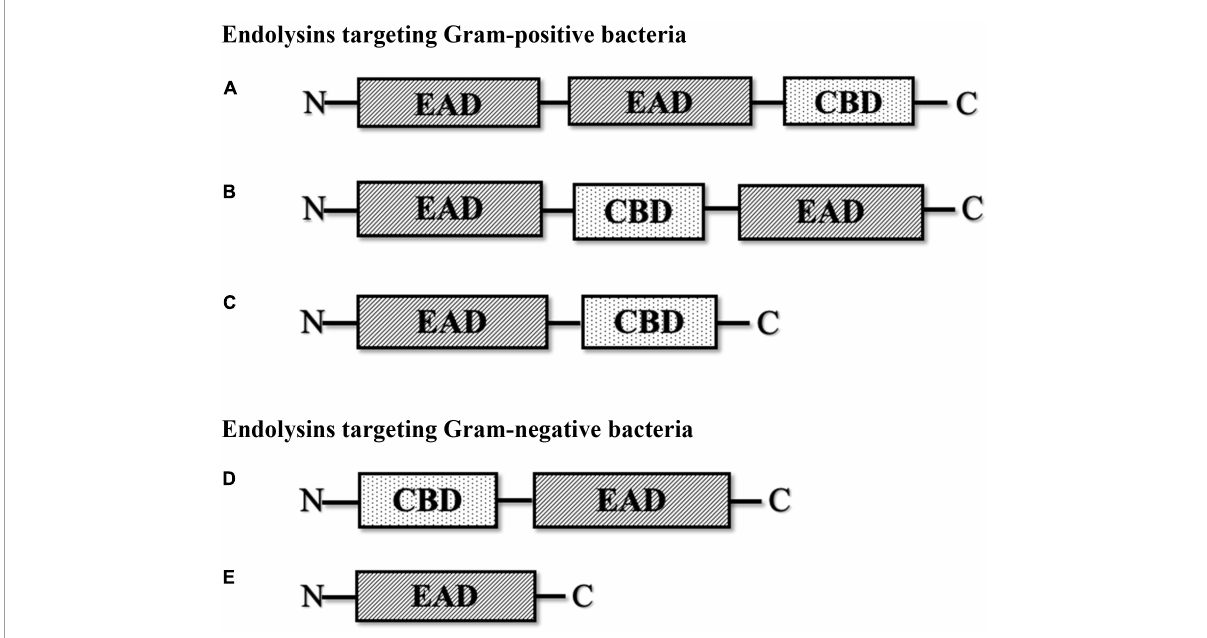
FIGURE1 Schematic structure of various types of phage-encoded peptidoglycan hydrolases (endolysin). (A) Multi-domain endolysin with more than one enzymatically active domain (EAD) and one C-terminal cell wall-binding domain (CBD). (B) Multi-domain endolysin with a centrally located CBD separating two EADs, found in Streptococcus phage ( λ Sa2). (C) Endolysin with an N-terminal EAD and a C-terminal CBD, another common structure of endolysin, mostly found in streptococcal endolysins and phages infecting Listeria , Clostridium , and Bacillus . (D) Endolysin with an N-terminal CBD and a C-terminal EAD, found in some Pseudomonas phages (KZ114 and EL188). (E) Globular endolysin with only one EAD, found in most Gram-negative